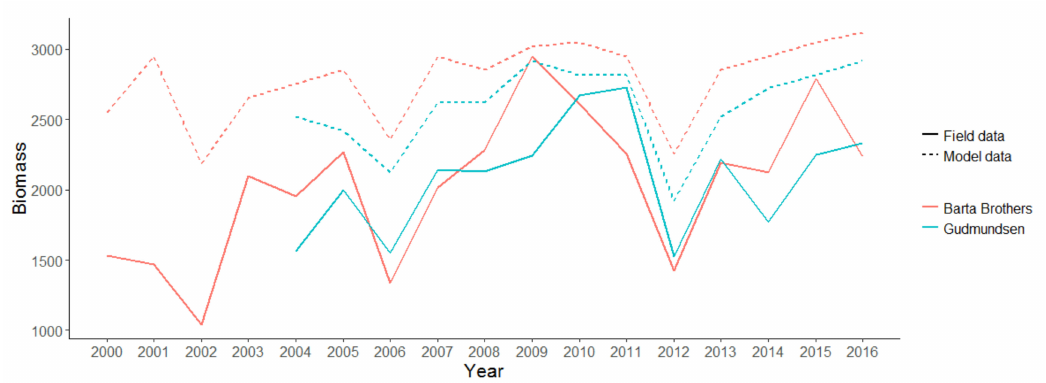
Figure 6. Time series of biomass derived from the EEP model (dashed lines) and field observation (solid lines) in two locations in Sandhills—the Barta Brothers Ranch (orange) located in the eastern part of the region and the Gudmundsen Sandhills Laboratory (blue) located in the central part.